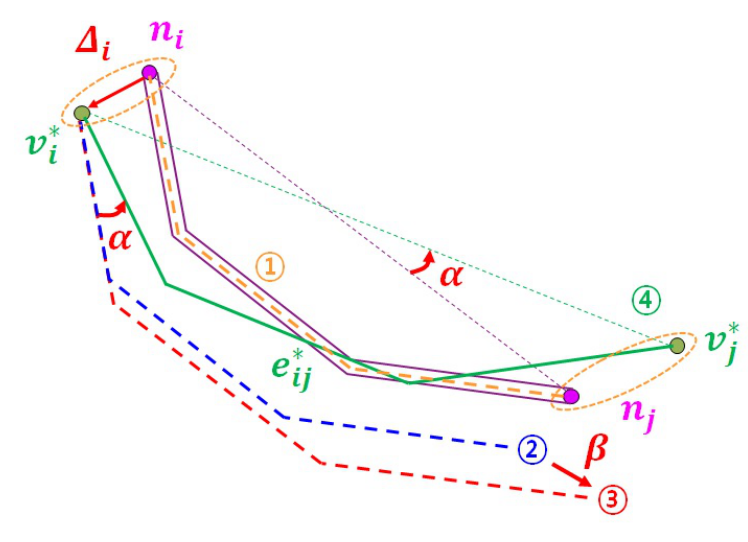
Figure 10. Example of OEI scheme for correspondent-missing NLM link l ij